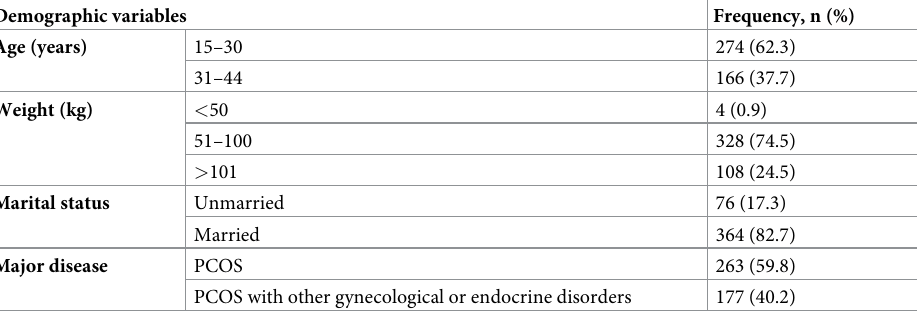
Table 1. Patient demographics (N =